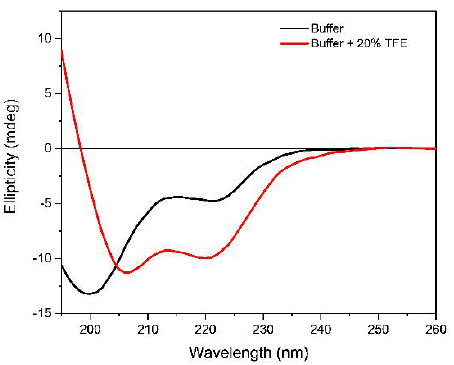
Figure 2. Far-UV CD spectra of Rhau25 peptide (0.09 mg/mL or 30.5 µ M) in 10 mM Tris-HCl buffer, pH 7.4, (black line) and in presence of 20% v / v trifluoroethanol (red line).